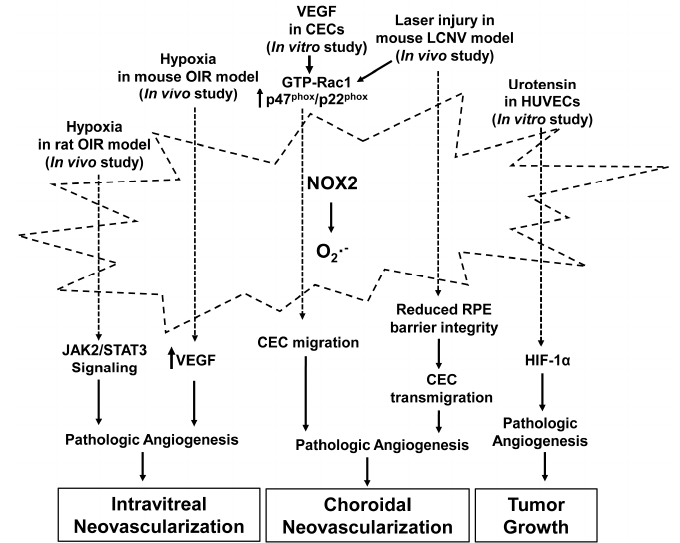
Figure 2. Activation of NADPH oxidase 2 (NOX2) in pathologic angiogenesis. NOX2 is activated by stimuli, including hypoxia, vascular endothelial growth factor (VEGF), laser injury and urotensin, and generates the superoxide radical that promotes pathologic angiogenesis through signaling pathways involved in intravitreal neovascularization, choroidal neovascularization and tumor growth. The stimuli designate pathways that have been reported in the literature but do not imply exclusivity. CECs: choroidal endothelial cells; HIF-1: hypoxia-inducible factor-1; LCNV: laser-induced choroidal neovascularization; RPE: retinal pigment epithelial; (JAK2)/STAT3: Janus kinase 2/Signal transducer and activator of transcription